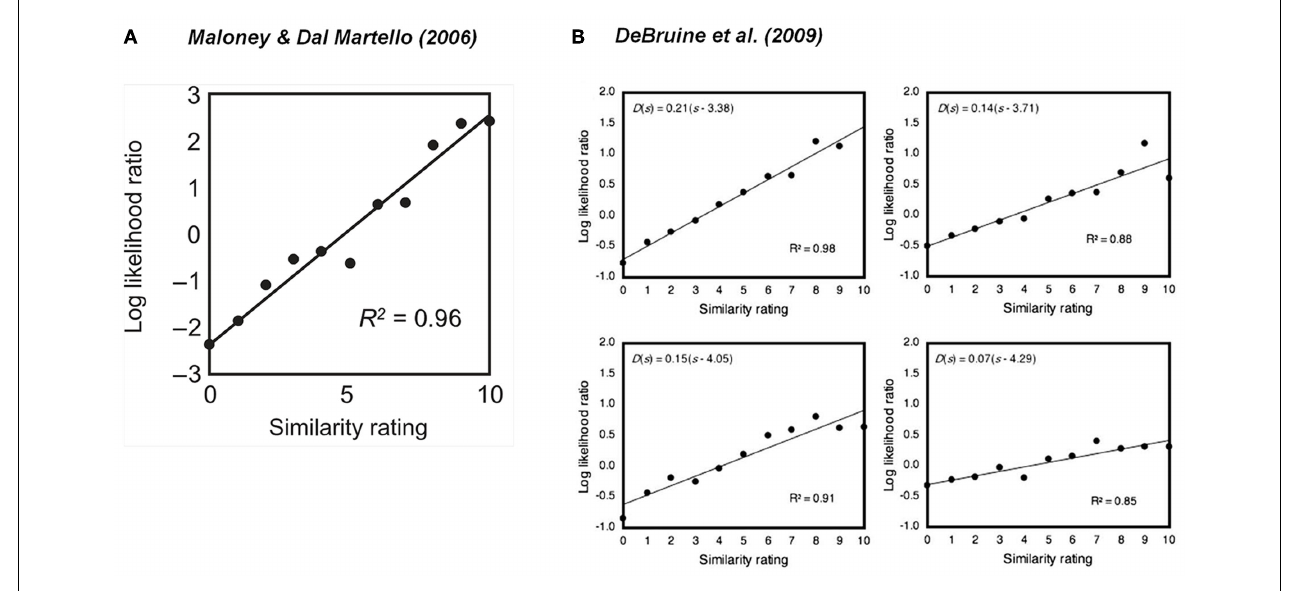
odds of the two children being judged to be related. Reproduced from Maloney and Dal Martello (2006). (B) The similarity rating of two adult faces is a linear transformation of the log odds of the two adults being judged to be related. Reproduced from DeBruine et al. (2009). R 2 denotes the proportion of variance accounted by the linear fit. See text for